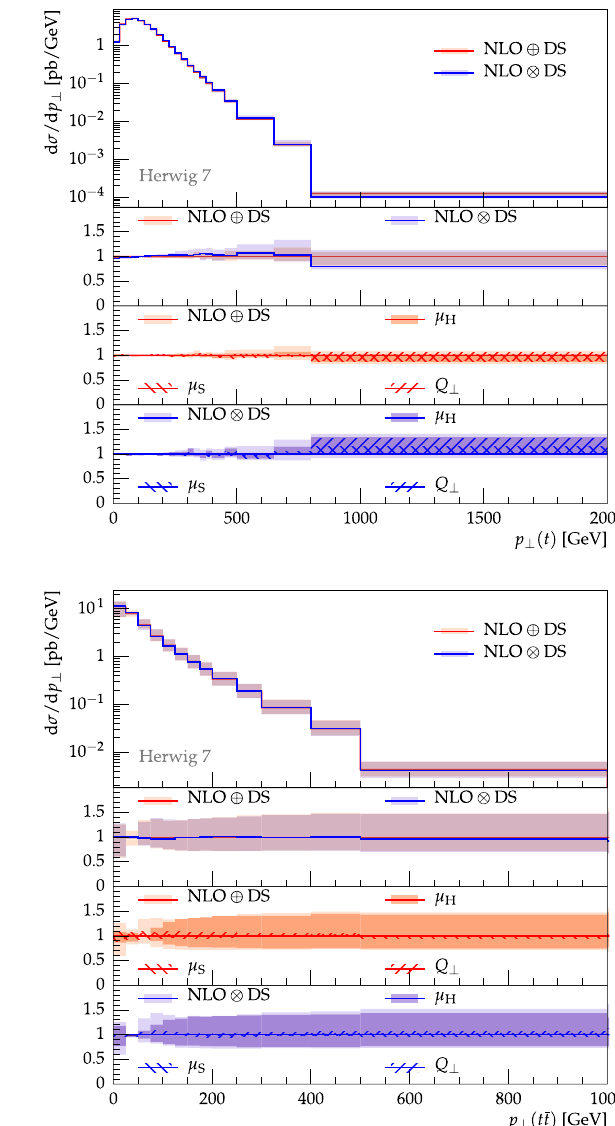
Fig. 7 Transverse momenta of the top quark (upper row) and the top quark pair (lower row), comparing variations for NLO matched predic- tions at 13 TeV for the angular-ordered (PS, left column) and dipole showers (DS, right column). The top panels in each plot compare the central prediction and overall variation between the MC@NLO-type (NLO ⊕ ) and Powheg-type (NLO ⊗ ) matching. The first ratio plot in